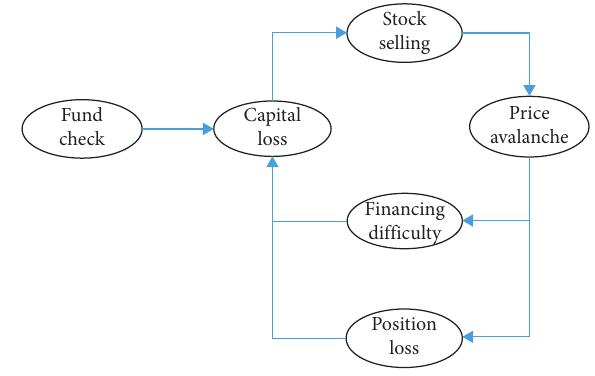
Figure 6: Liquidity